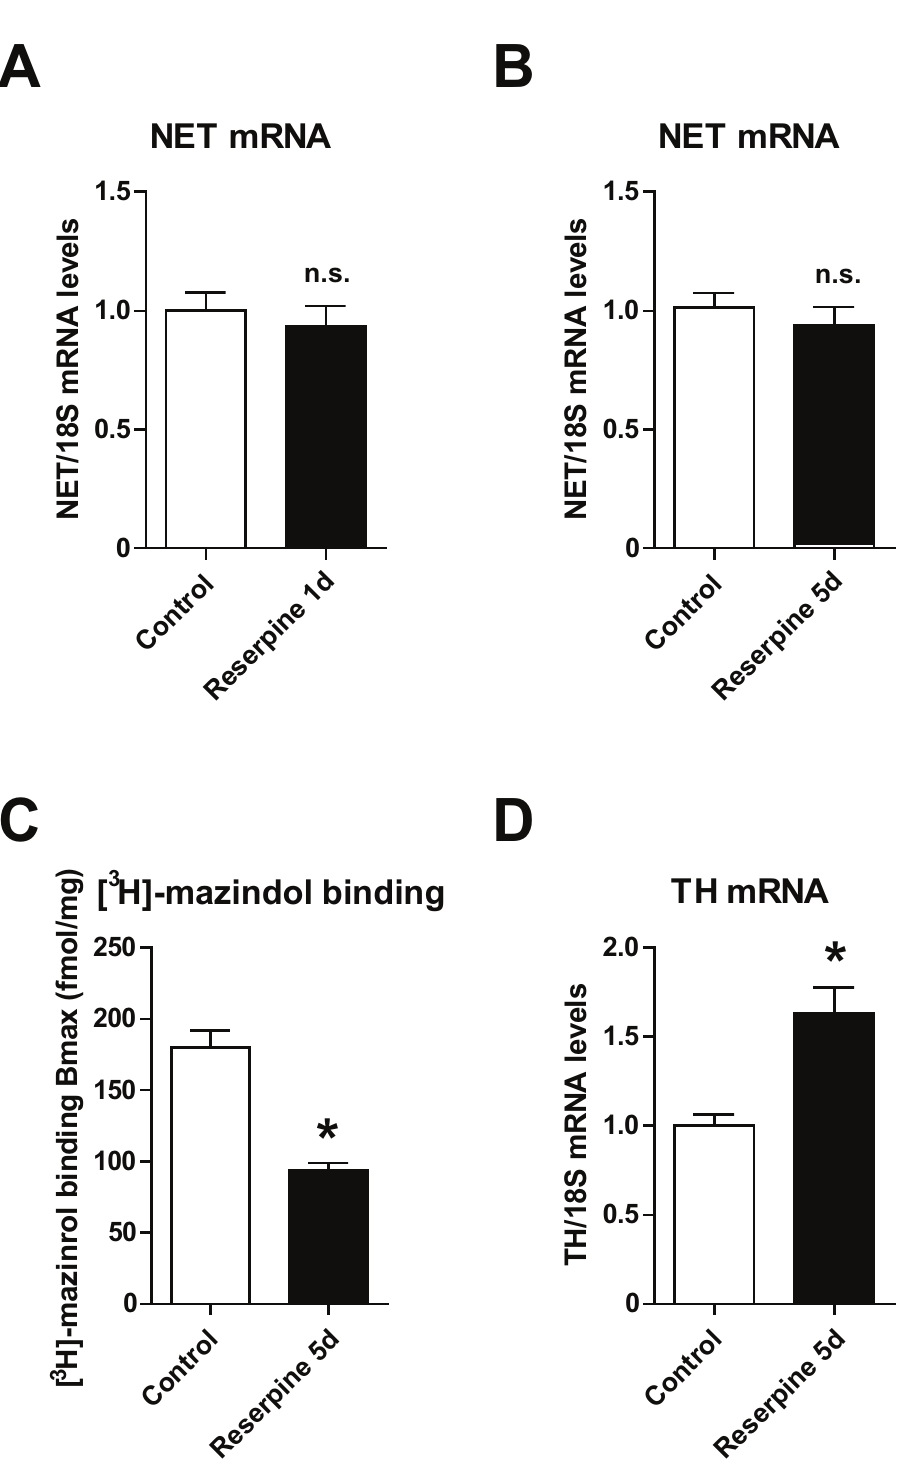
Fig 4. Downregulation of the norepinephrine (NE) transporter (NET) after NE depletion. Gene expressionof the NET after one day (1d) (A) and five days (5d) (B) of treatment with reserpine(5 mg/kg/d) or saline(control), normalizedto 18S mRNA expression, respectively(n (cid:21) 5 for each group). (C) Myocardial density of the NET measuredas binding of [ 3 H]-mazindol to cardiac membranes (normalizedto mg total protein; n = 6 per group) and (D) expressionof the tyrosine hydroxylase(TH) (normalizedto 18S